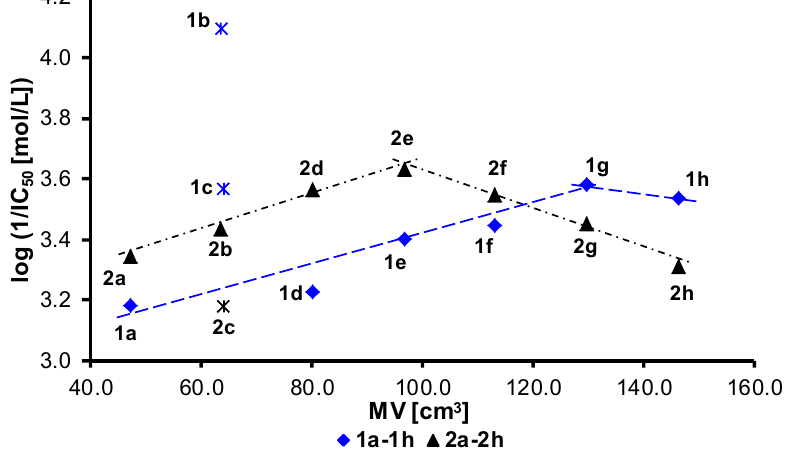
Figure 2. Dependence of PET-inhibiting activity log(1/IC 50 [mol/L]) of carbamates 1a – 1h and 2a – 2h in spinach chloroplasts on bulkiness of R 2 substituents expressed as molar volume MV [cm − 3 ] of alkyl tail of compounds.